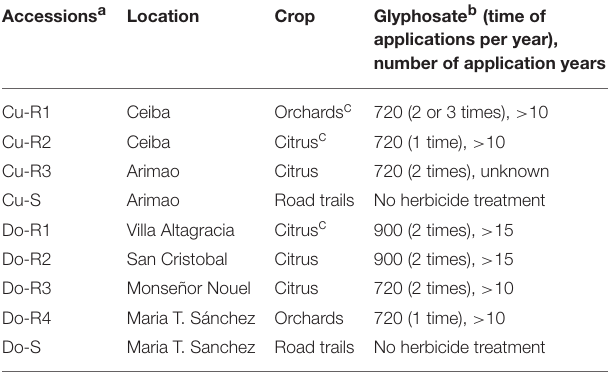
TABLE 1 | History of different P. hysterophorus accessions used in this study. Accessions a Location Crop Glyphosate b (time